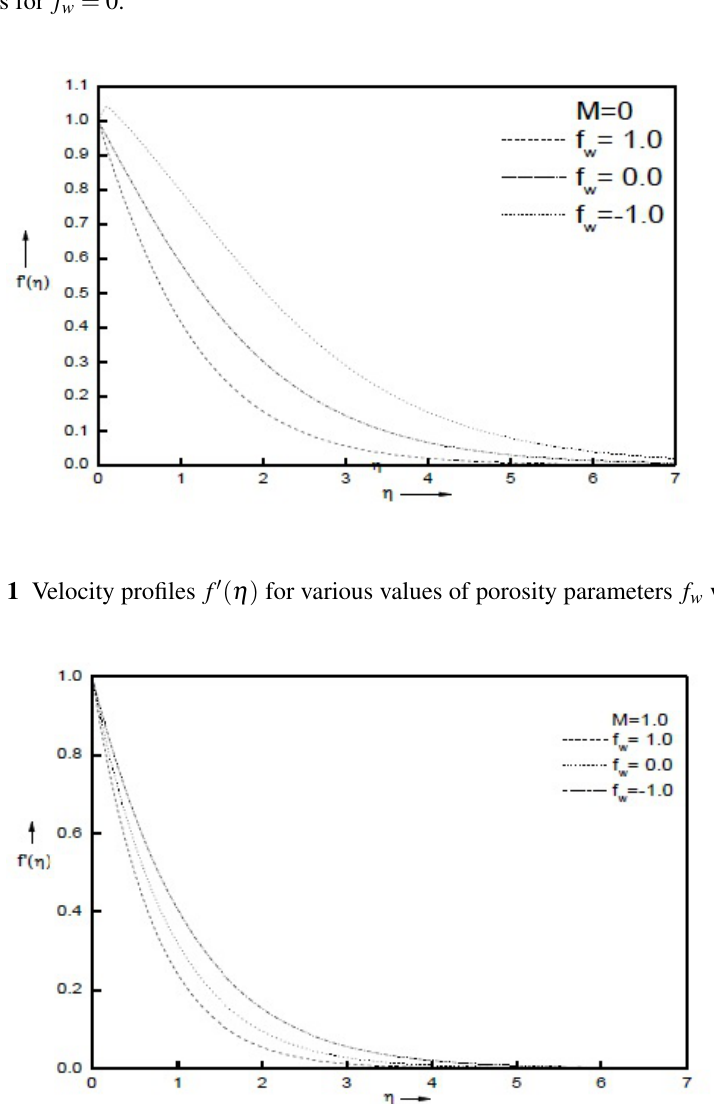
Table 2 Various values of magnetic parameters M obtained by Dirichlet series and method of stretching of variables with their numerical values for f w = 0.